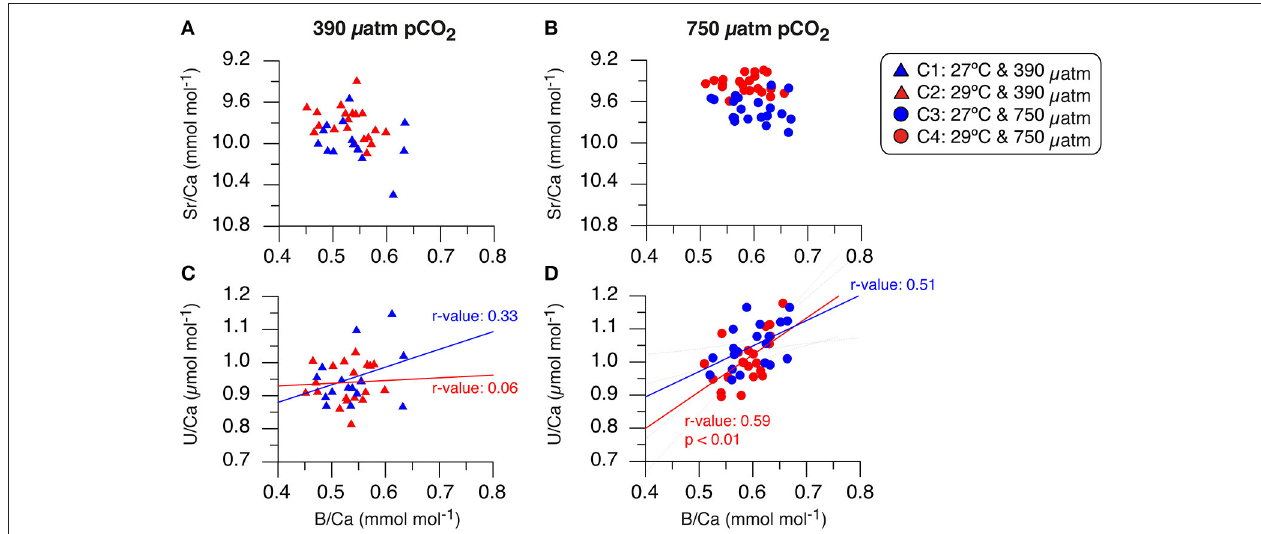
FIGURE 6 | Sr/Ca and U/Ca ratios relationship to B/Ca ratio in primary polyp A. millepora juvenile coral. The Sr/Ca (mmol mol − 1 ) and U/Ca ( µ mol mol − 1 ) plots are oriented based on pCO 2 concentration with the left column for the experiments at 390 µ atm pCO 2 and the right column for the conditions at 750 µ atm pCO 2 . (A) Sr/Ca and B/Ca ratios of condition 1 (blue triangle) and condition 2 (red triangles), (B) Sr/Ca and B/Ca ratios of condition 3 (blue circles) and condition 4 (red circles). Note that Sr/Ca ratios are inversely plotted to reflect the temperature relationship of lower (higher) Sr/Ca with higher (lower) temperature. (C) U/Ca and B/Ca ratios of condition 1 (blue triangle) and condition 2 (red triangles), (D) U/Ca and B/Ca ratios of condition 3 (blue circles) and condition 4 (red circles). Correlation relationships between U/Ca and B/Ca are shown in respective colors with Pearson Product Moment correlation coefficients listed indicating strength of association and significance ( p < 0.01). The 1 σ standard deviation (SD) of the measured NIST SRM 610 and JCp-1 coral standard for trace element/Ca ratios are listed in Figure 5 .